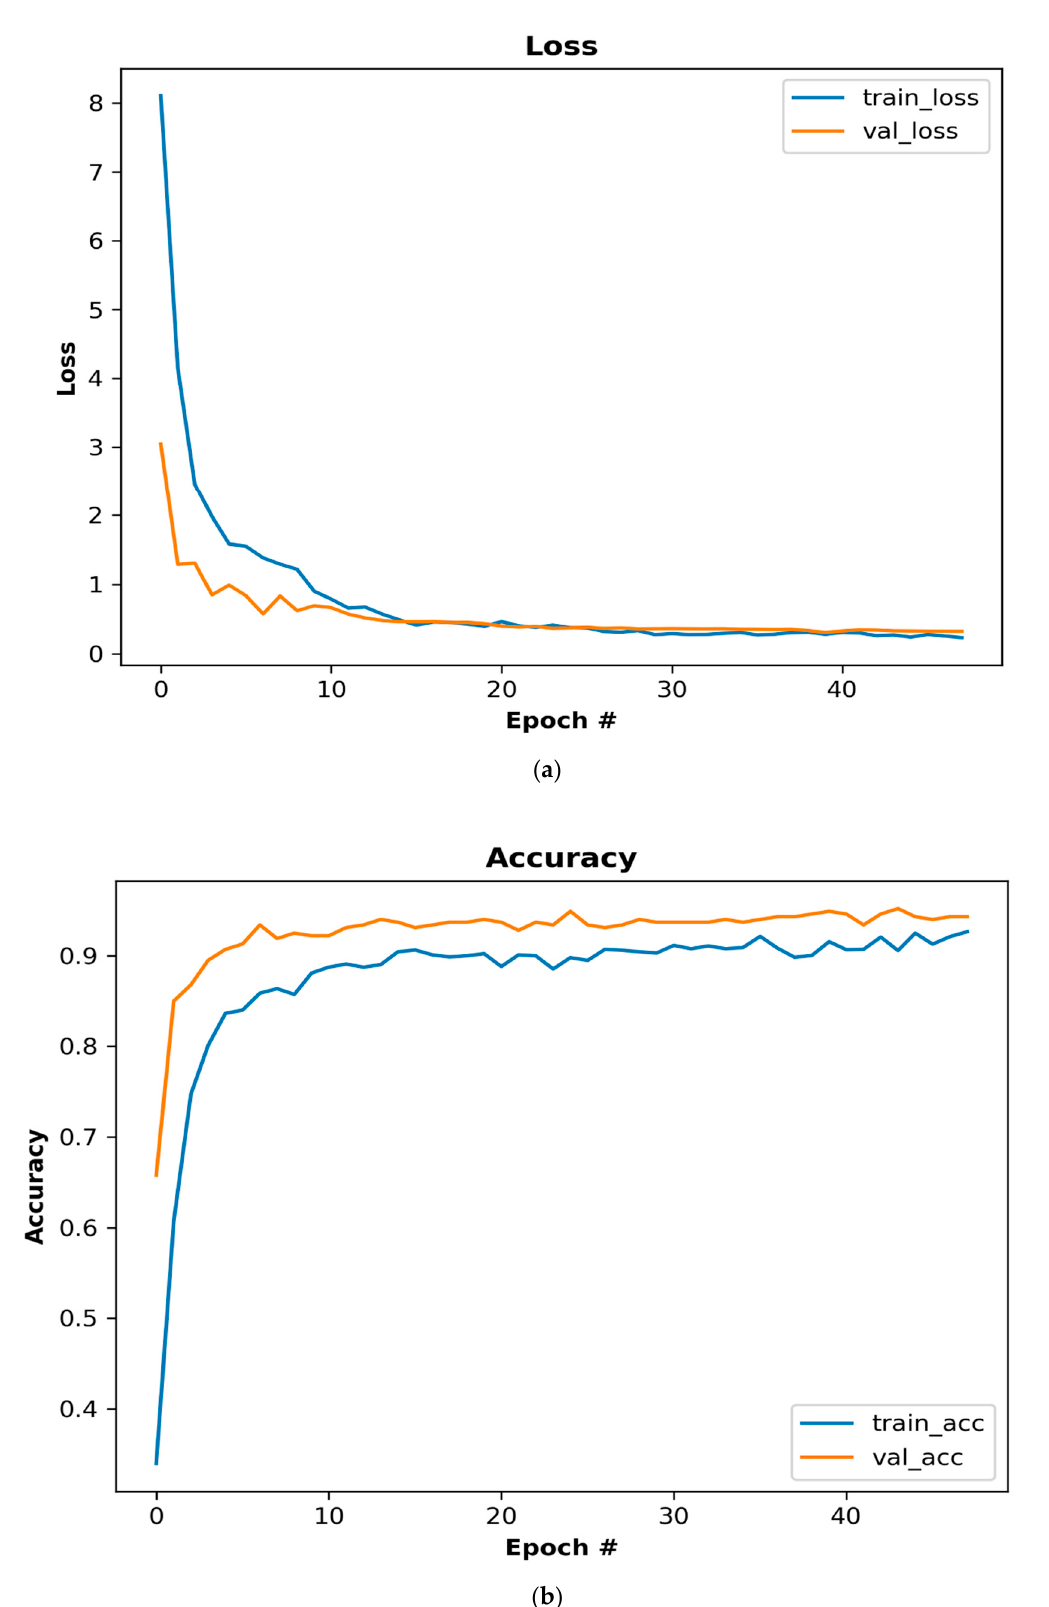
Figure 21. ( a ) Epochs vs. loss plot. ( b ) Epochs vs. accuracy plot.